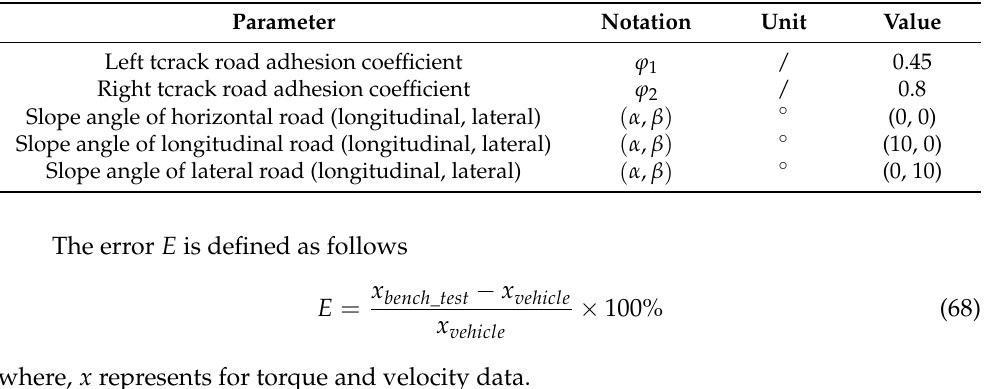
Figure 23. Simulation results of the motor load simulation: ( a ) with ramp signal input, ( b ) with pulse signal input. Table 2. Main parameters of mu-split road